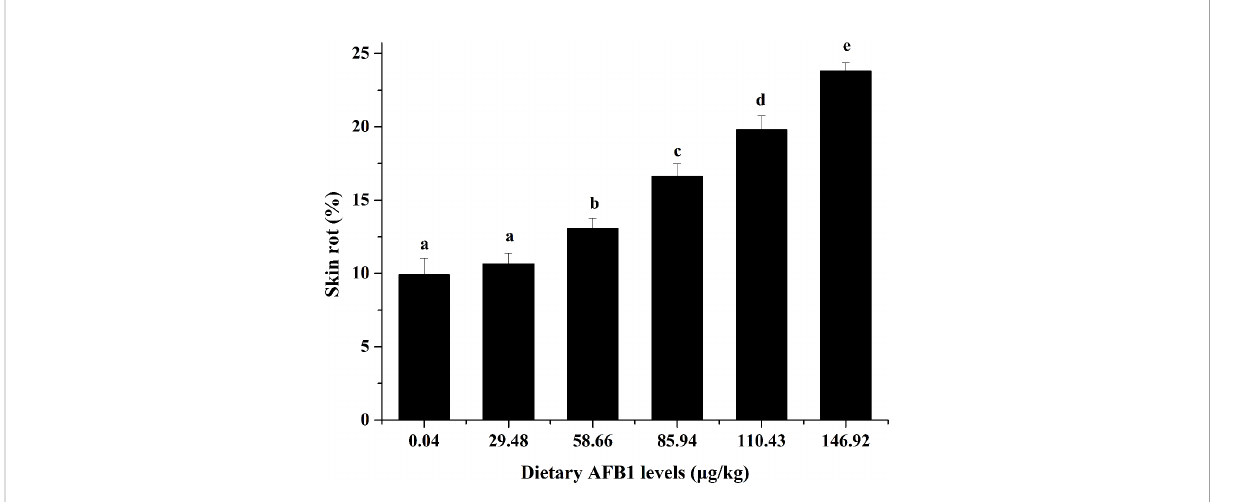
FIGURE 1 Effects of dietary AFB1 ( m g/kg) on skin rot of grass carp after challenged with A. hydrophila . n=6 (six fi sh in each group). Different letters indicate signi fi cant differences (P < 0.05).